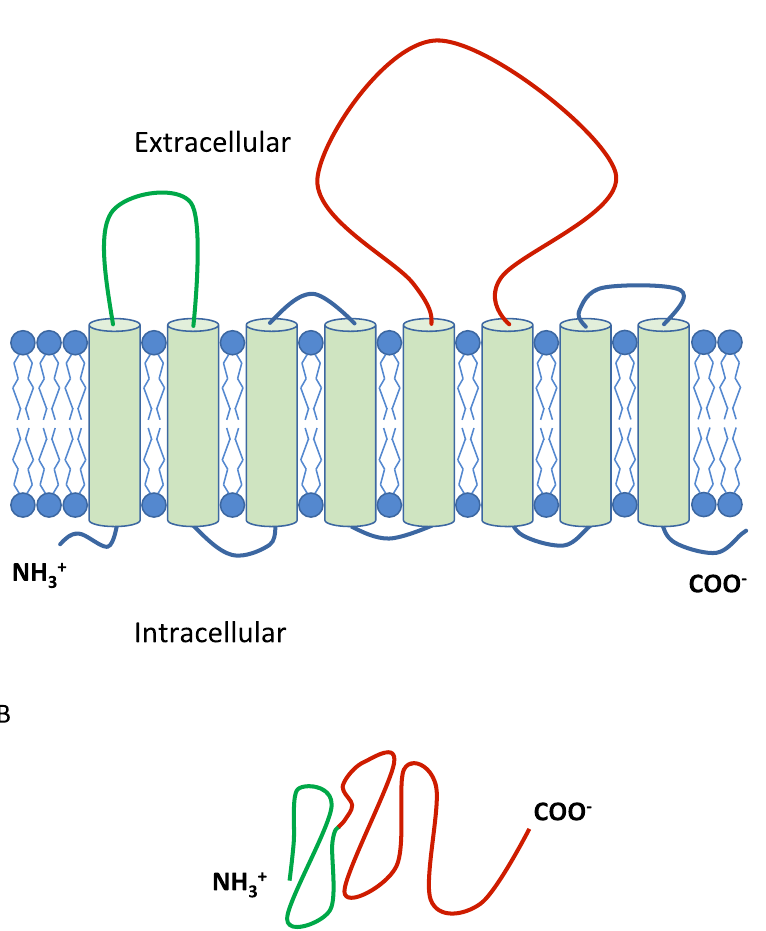
Figure 1. Illustration of SERoM di-polypeptide construction strategy. ( A ) Two dimensional depiction of an example MmpL protein. SERoM regions highlighted in green (R1) and red (R2). Transmembrane regions (8 of 12 shown) shown as barrels. ( B ) Example structure of SERoM di-polypeptide fusion vaccine, comprised of extracellular regions R1 and R2.